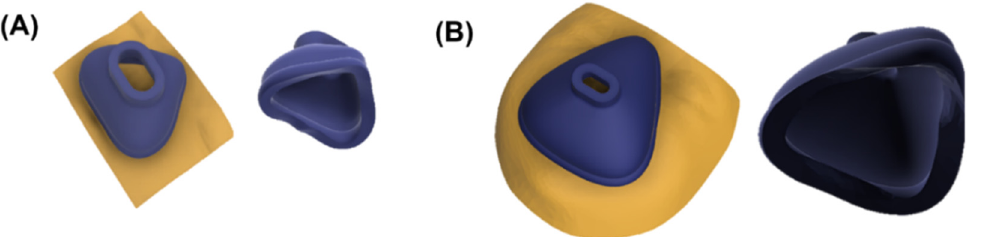
Figure 5. Fitted nasal and oronasal mask. ( A ) Nasal mask with (left) and without scan (right); ( B ) Oronasal mask with (left) and without scan (right).